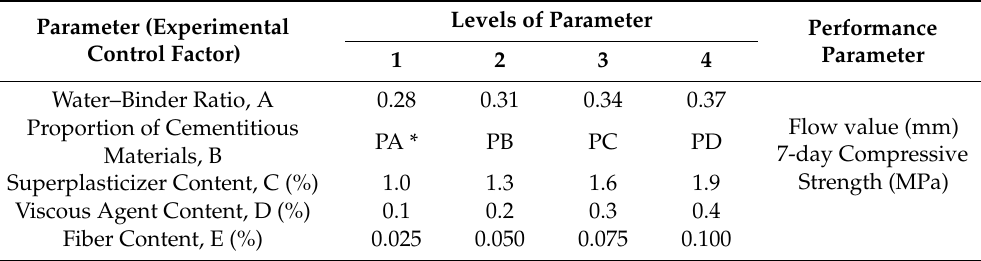
Table 2. Parameters and design levels for matrix.